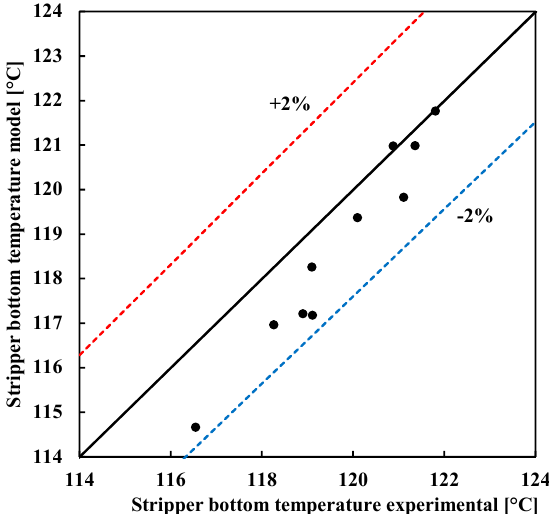
Figure 3. Parity plot for stripper bottom temperature for the 10 steady-state operation cases. Lines for +2% and − 2% percentage errors are shown. The mean percentage error is 0.86 for stripper bottom temperature.